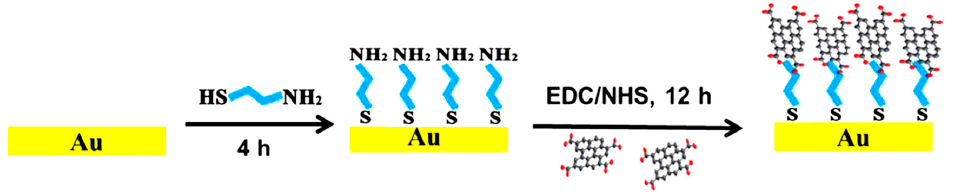
Copyright (2013) Royal Society of Chemistry. Abbreviations: EDC, 1-Ethyl-3-(3-dimethylaminopropyl) carbodiimide; NHS, N